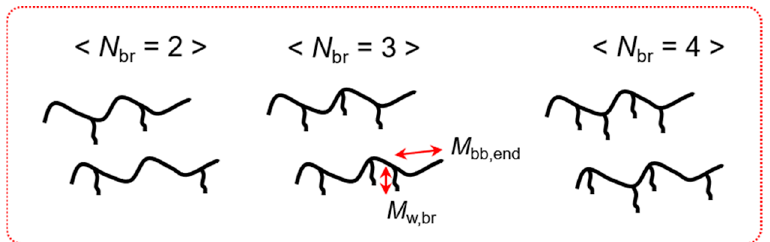
Figure 3. Possible structures of PS290-3-44. M w,br is the branch molecular weight and M bb,end is the molecular weight of the backbone end part.